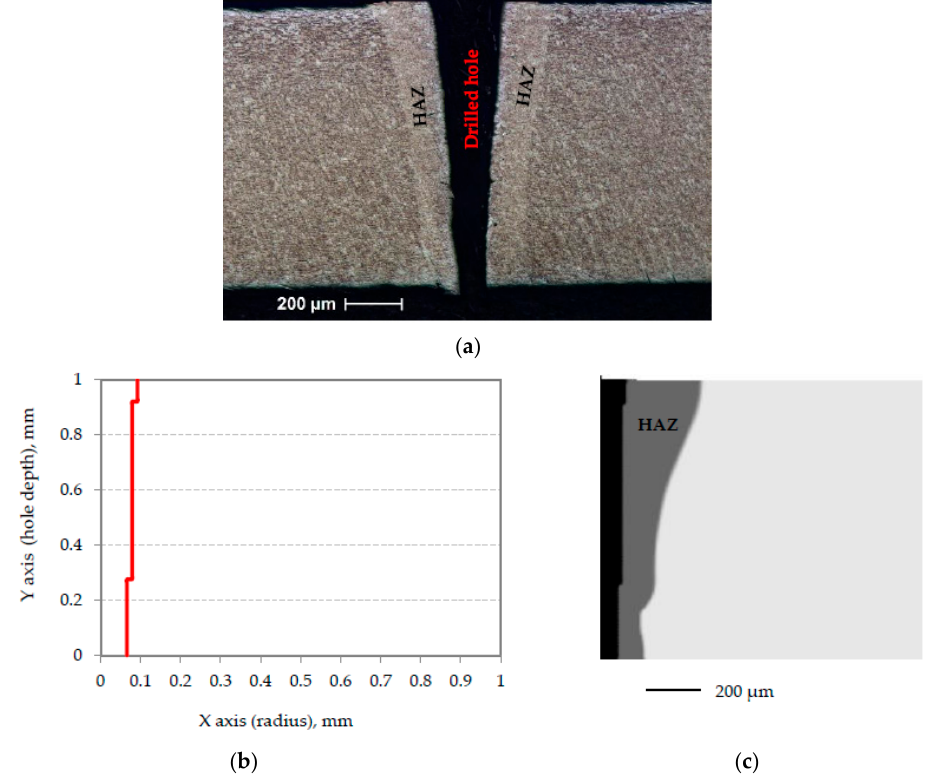
Figure 7. Heat-affected zone (HAZ) and the shape of the drilled hole for a 1-mm-thick tungsten alloy plate: ( a ) Experiment; ( b ) FVM—shape of the hole; ( c ) FVM—heat-affected zone [14].